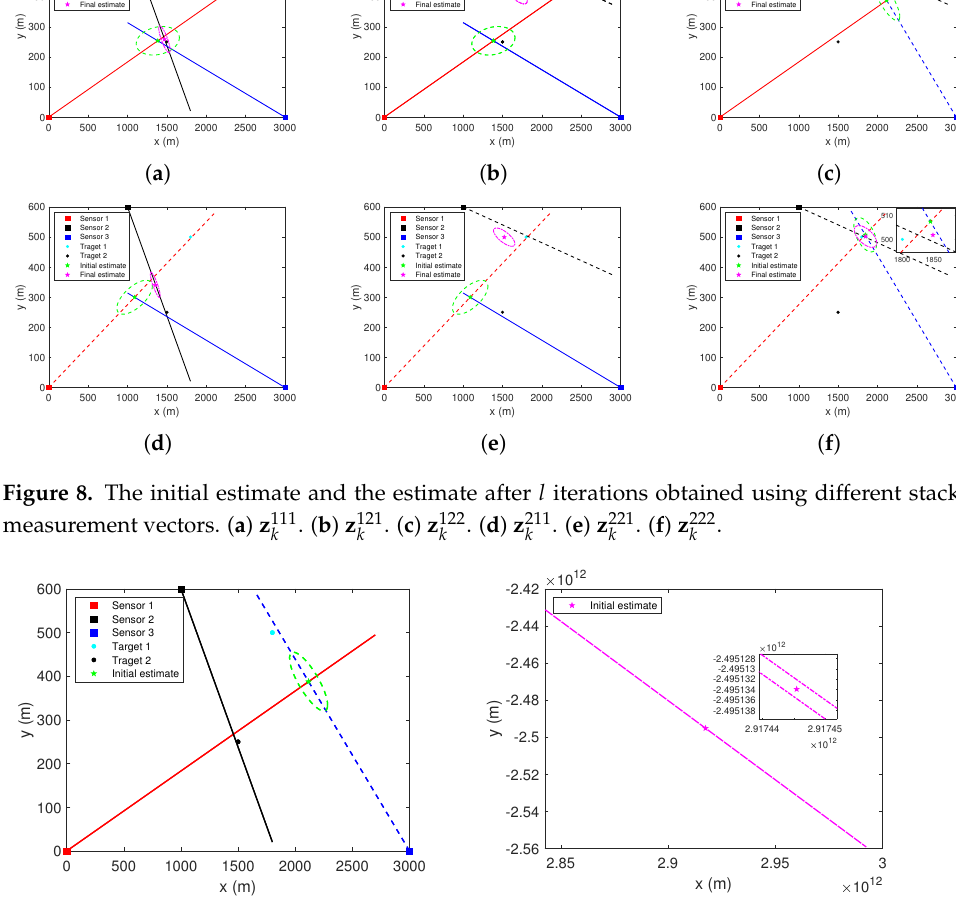
Figure 9. The initial estimate and the estimate after l iterations obtained using the stacked measure- ment vector z 112 . ( a ) Initial estimate. ( b ) Estimate after l k